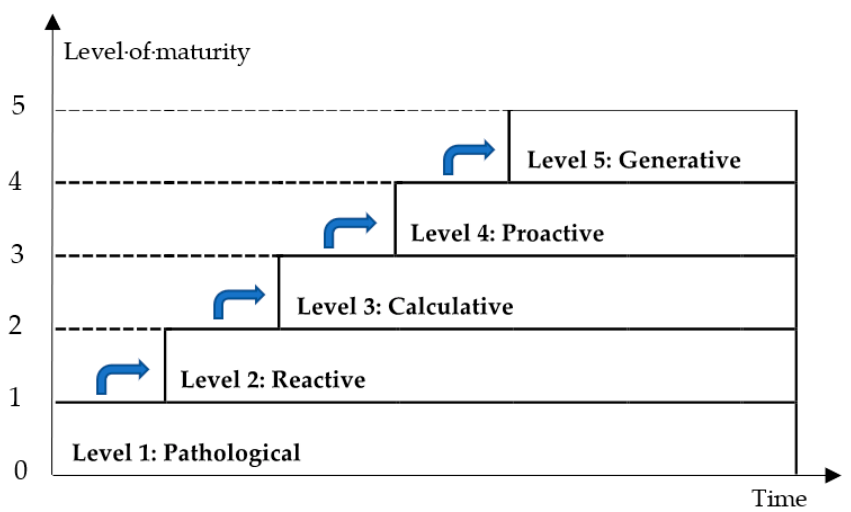
Figure 2. Resilient safety culture maturity levels.